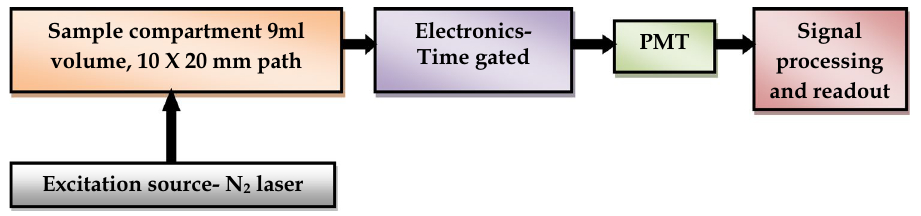
Table 1 The order of dominance of cations and anions in different seasons